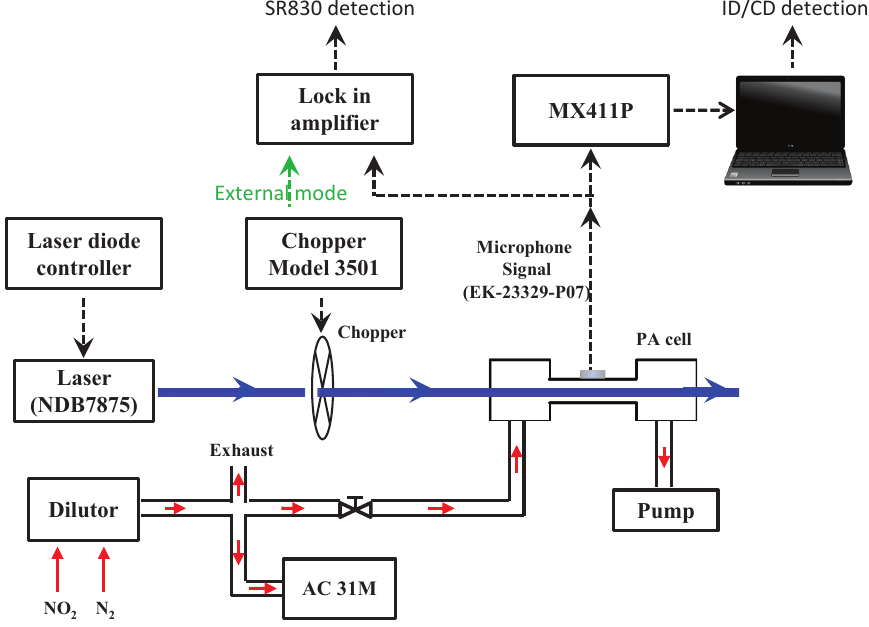
Figure 7. Experimental set up of photoacoustic spectroscopy (PAS)-based NO 2